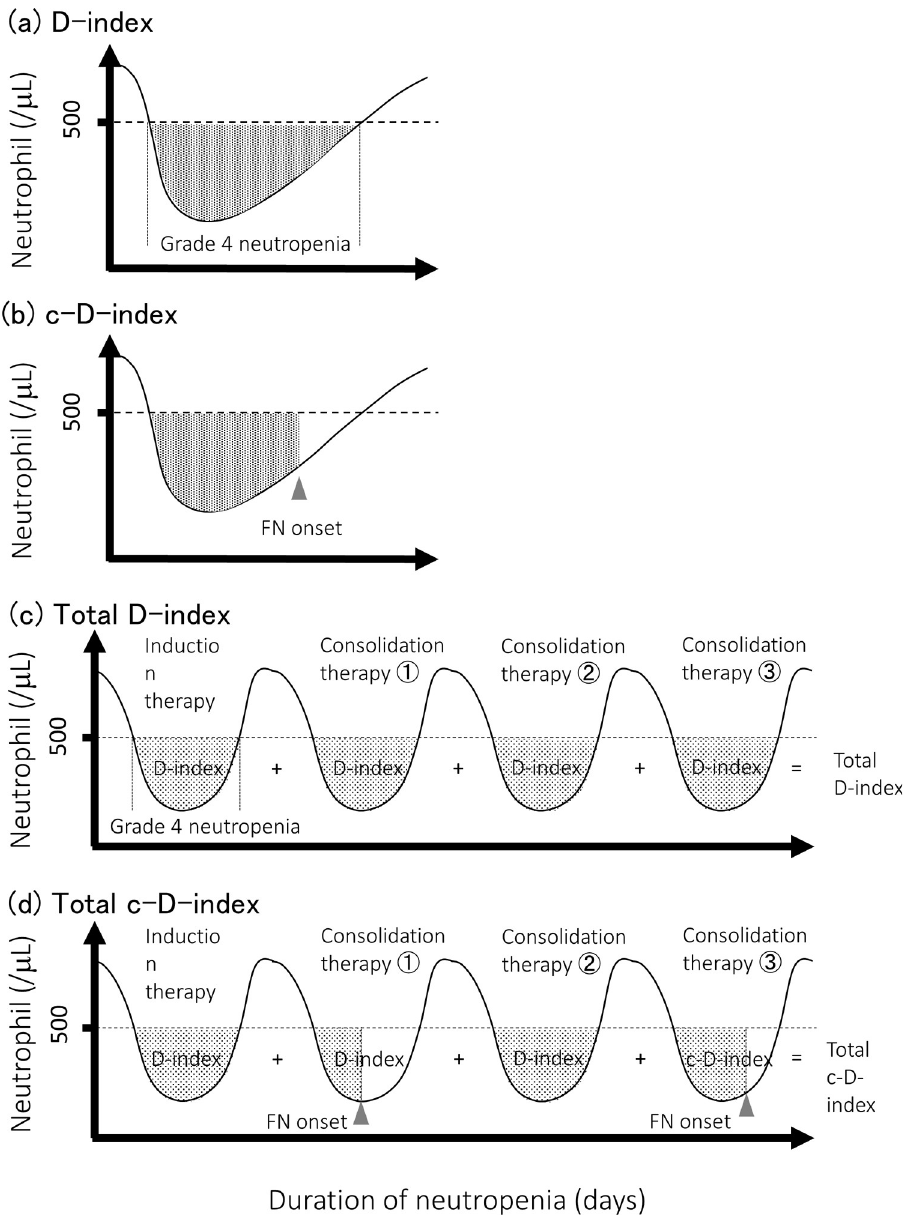
Fig 1. Definitions of the four indices investigated. The D-index, total D-index, cumulative D-index (c-D-index), and total c-D-index are depicted on the neutrophil count curve for a patient undergoing induction therapy and three periods of consolidation therapy. FN, febrile